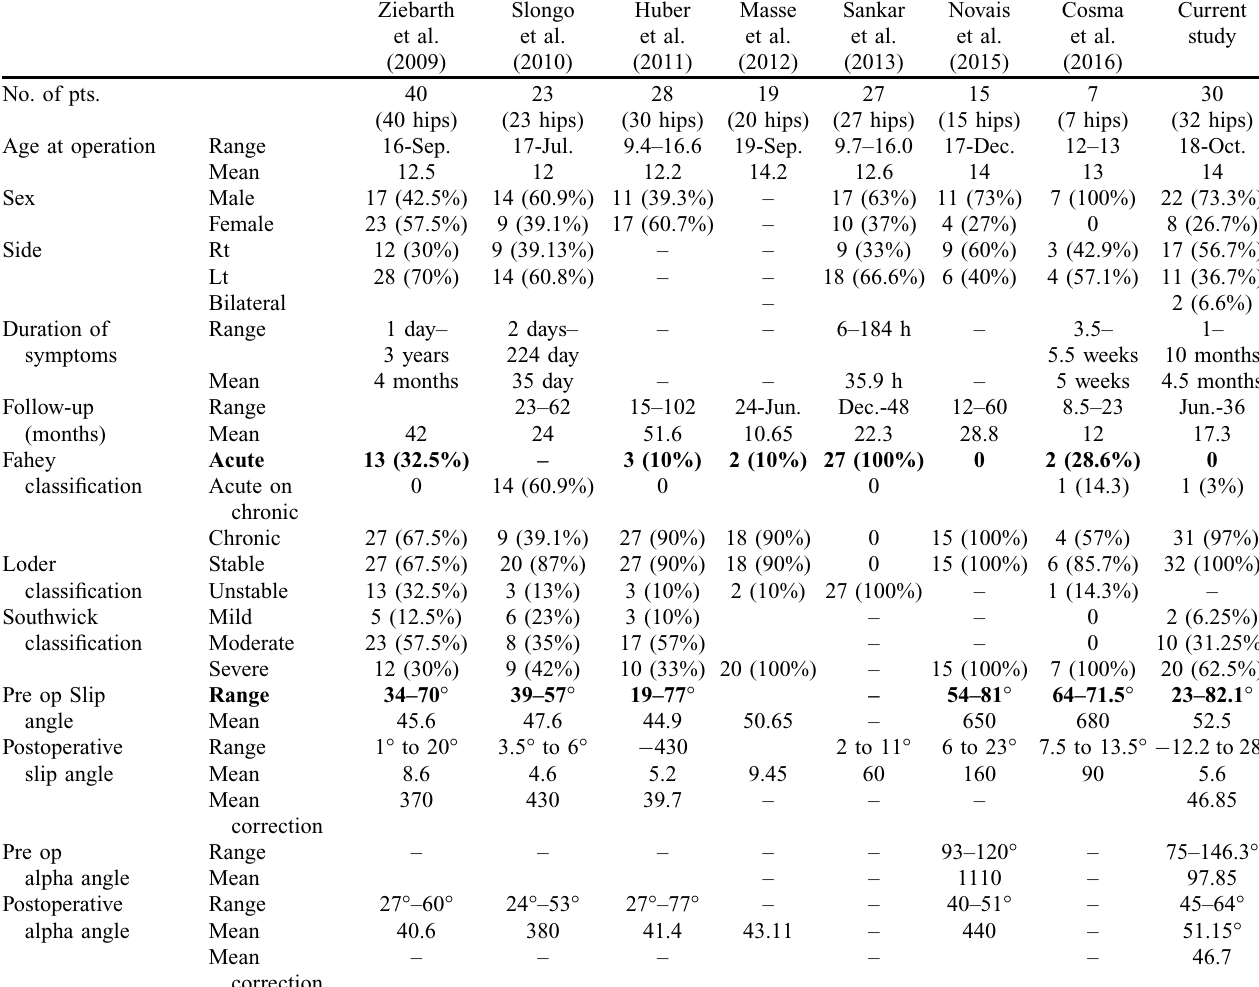
Table 4. Comparison of patient criteria in different